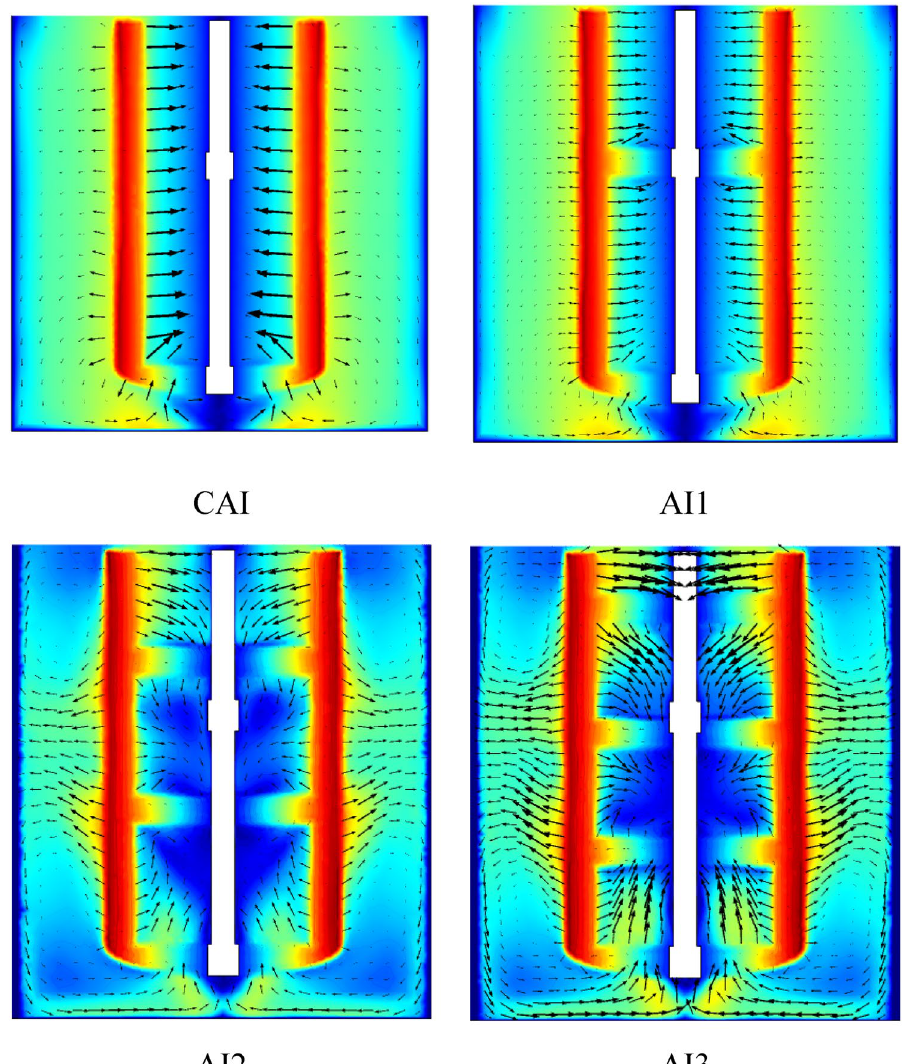
Figure 24. Velocity magnitude and vectors filed distribution on the vertical section of the vessel with different geometry